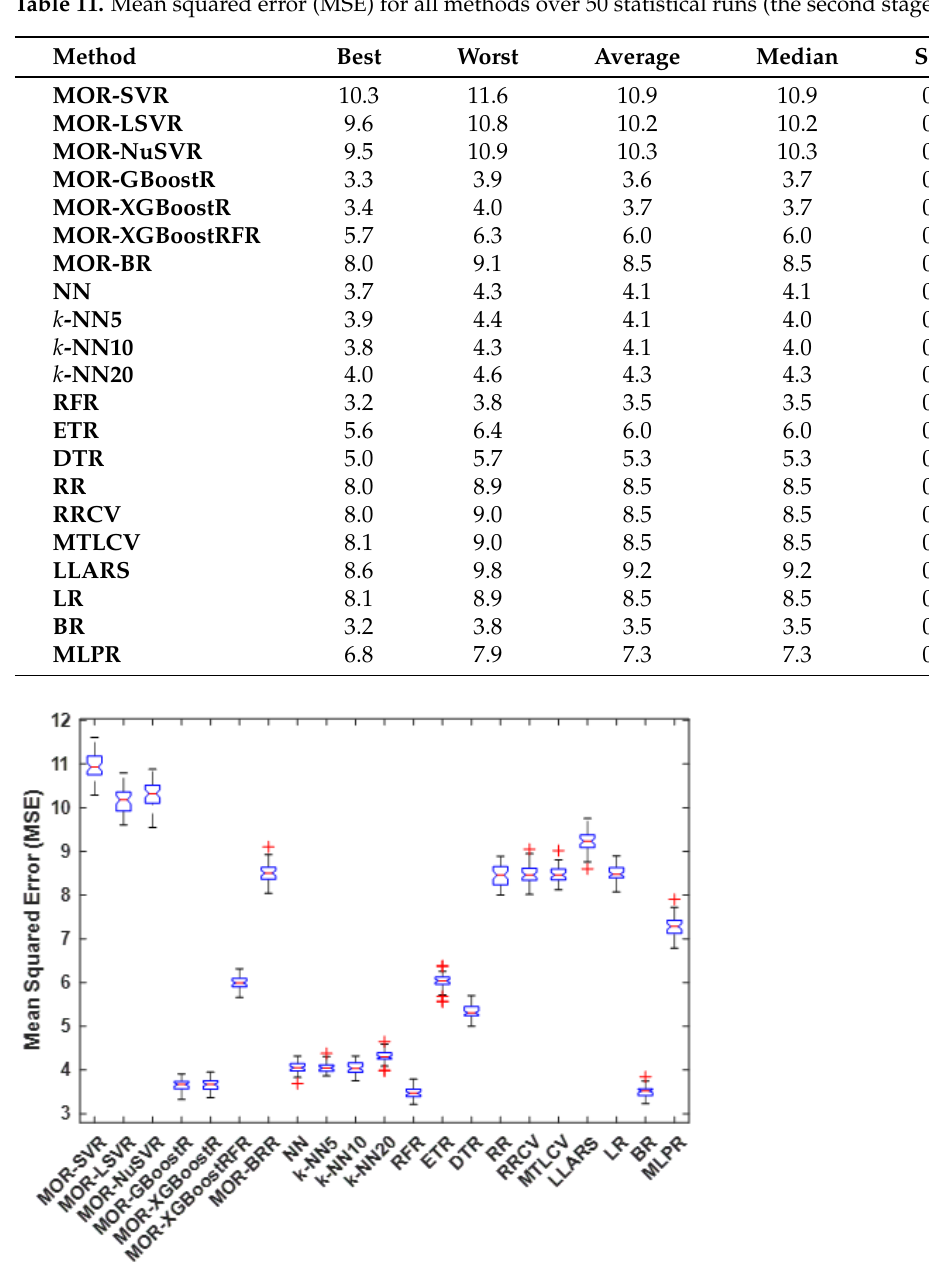
Figure 10. Box plots of MSE (over 50 statistical runs) for all methods for the second